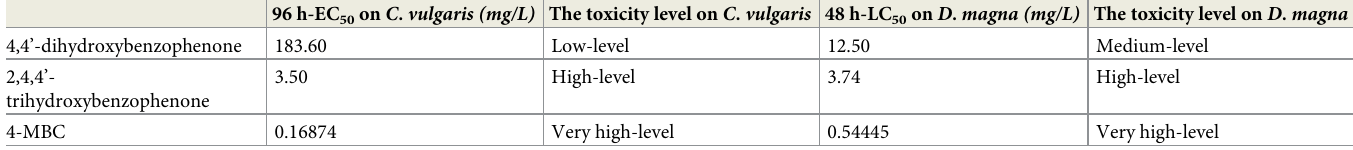
Table 3. Acute toxicity of 4,4’-dihydroxybenzophenone, 2,4,4’-trihydroxybenzophenone and 4-MBC. 96 h-EC 50 on C . vulgaris (mg/L) The toxicity level on C . vulgaris 48 h-LC 50 on D . magna (mg/L) The toxicity level on D . magna